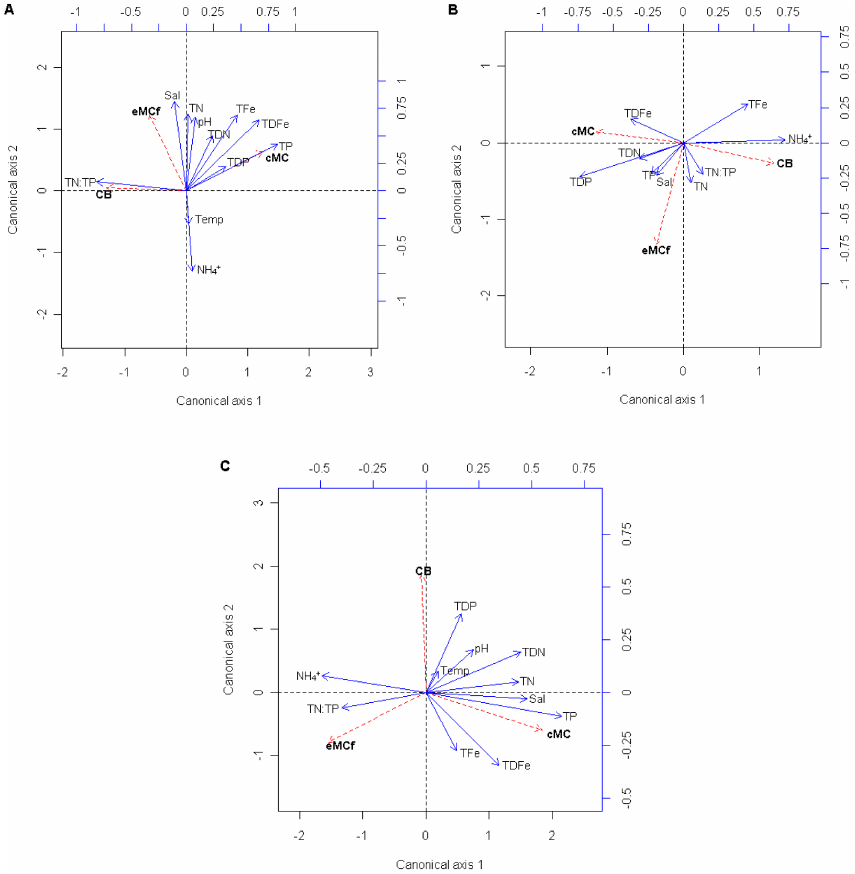
Figure 10. RDA biplots for the of environmental variables and the absolute cyanobacteria biomass (CB), cellular microcystin (cMC) and extracellular microcystin fraction (eMCf) in (a) Jackadder Lake, (b) Bibra Lake, (c) Yangebup Lake; solid arrows indicate environmental variables; short dashed arrows indicate response variables. Canonical axes 1 and 2 represent a linear combination of the environmental variables, and axes are scaled by the square root of their